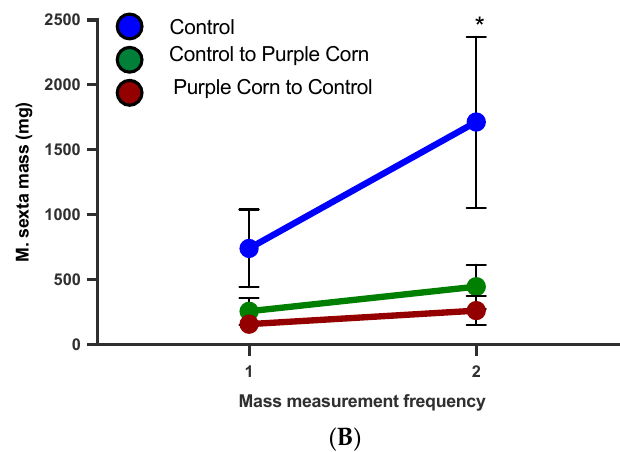
Figure 7. Mean larval mass before diet switch ( A ) and after diet switch ( B ) among different treatments. Groups with asterisks are statistical significant one-way ANOVA, unpaired t-test, Tukey’s HSD test, p < 0.05).